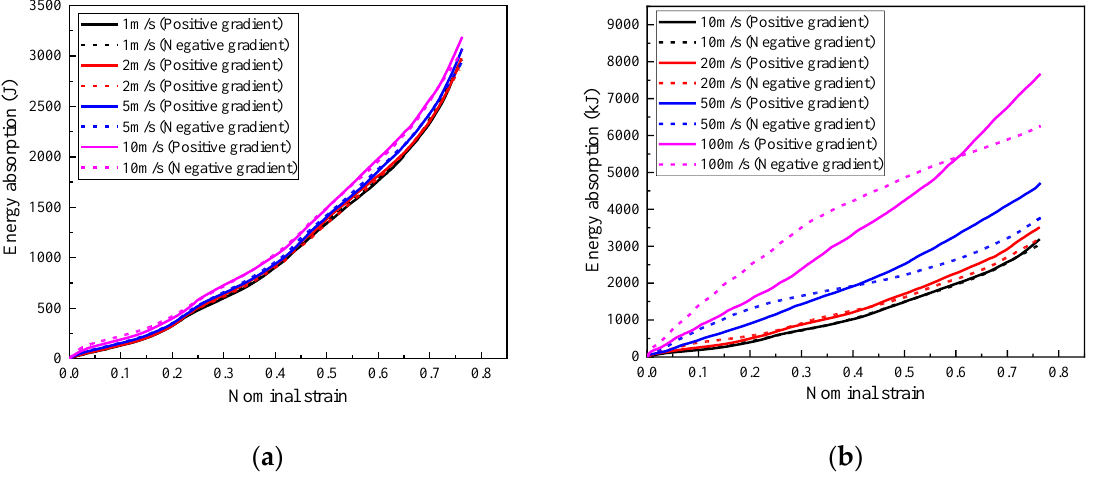
Figure 28. The energy absorption of the composite ( t = 0.4:0.4:0.4) with positive gradient ( ρ = 408:575:848) or negative gradinet ( ρ = 848:575:408) under different loading rates: ( a ) 1 m/s, 2 m/s, 5 m/s and 10 m/s; ( b ) 10 m/s, 20 m/s, 50 m/s and 100 m/s.